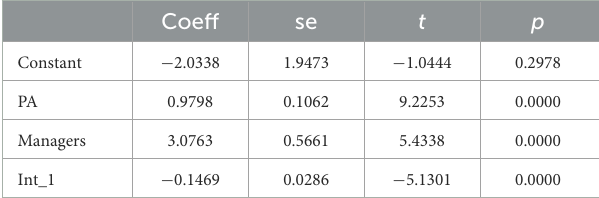
TABLE 6 Genuine acting and personal accomplishment, with feedback from the managers as the moderator.